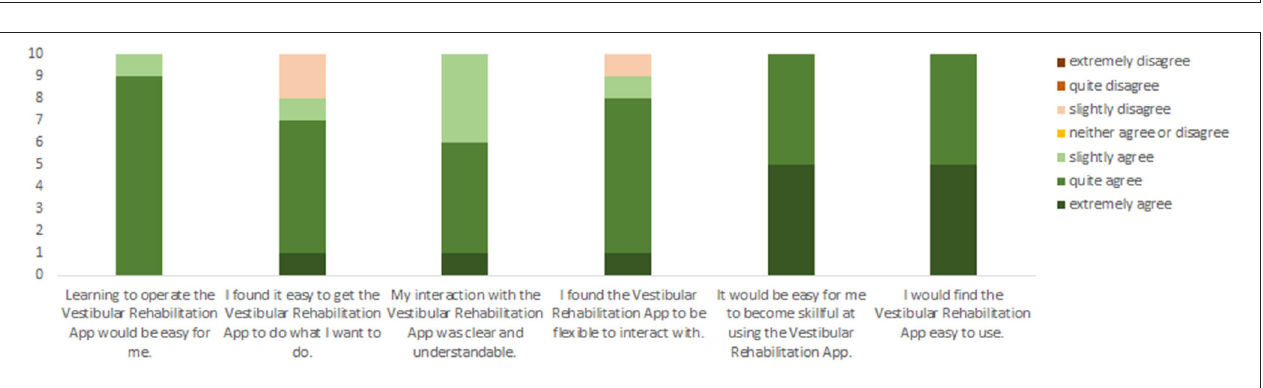
FIGURE 5 | Rating for the six questions on the perceived ease of use